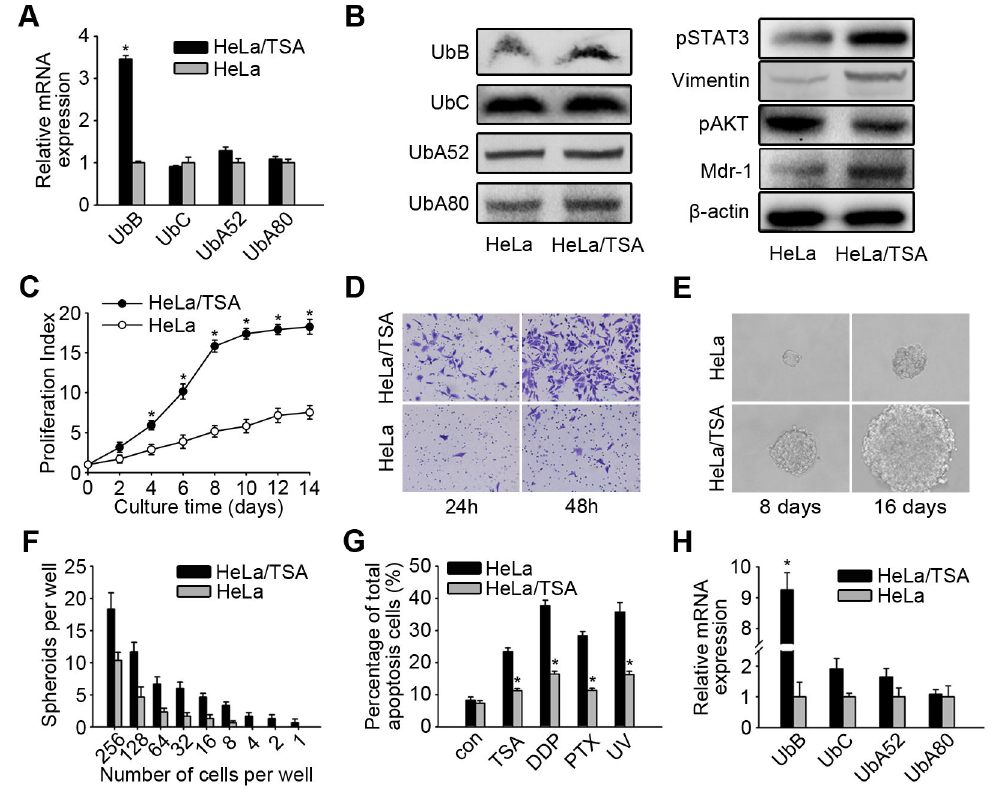
Figure 2. HeLa/TSA was up-expressed UbB and exhibited higher ability of the mammosphere formation. A , HeLa/TSA cells were analyzed for UbB, UbC, UbA52 and UbA80 mRNA levels. The columns represent the average of three separate experiments; error bars, SD; *, p <0.05. B , HeLa/TSA cells were analyzed for the protein levels of Ub proteins, pSTAT3, Vimentin, pAKT and Mdr-1, β-actin was used as a loading control. C , Quantitative analysis of the proliferation index determined by the CCK-8 assay for the indicated times. The results shown are averaged through three separate experiments; error bars, SD. D , Representative examples of tranwell assay were photographed at 200× magnifications. E , Themorphologic appearance of a representative mammosphere for the indicated times was photograghed at 200×magnifications. F , Spheroid formation assays were performed by limiting dilution with 256 cells to one cell per well of a 96-well Ultra-Low Adherent plate. This experiment was performed for triple times with six wells per well dilution. The number of colonies was counted at day 14. G , Mammosphere cells of HeLa and HeLa/TSA were re-cultured in an ordinary adherent plate for 24 h, and then treated with TSA, DDP, and PTX for 48 hours or UV for 5 min. The apoptosis cells were quantified using Annexin V/PI staining and the flow cytometry analysis. The values are average and SD (error bars) of 3 separate experiments, *, p <0.05. H , HeLa/TSA mammosphere cells were analyzed for UbB, UbC, UbA52 and UbA80 mRNA levels. GAPDH was used as a reference